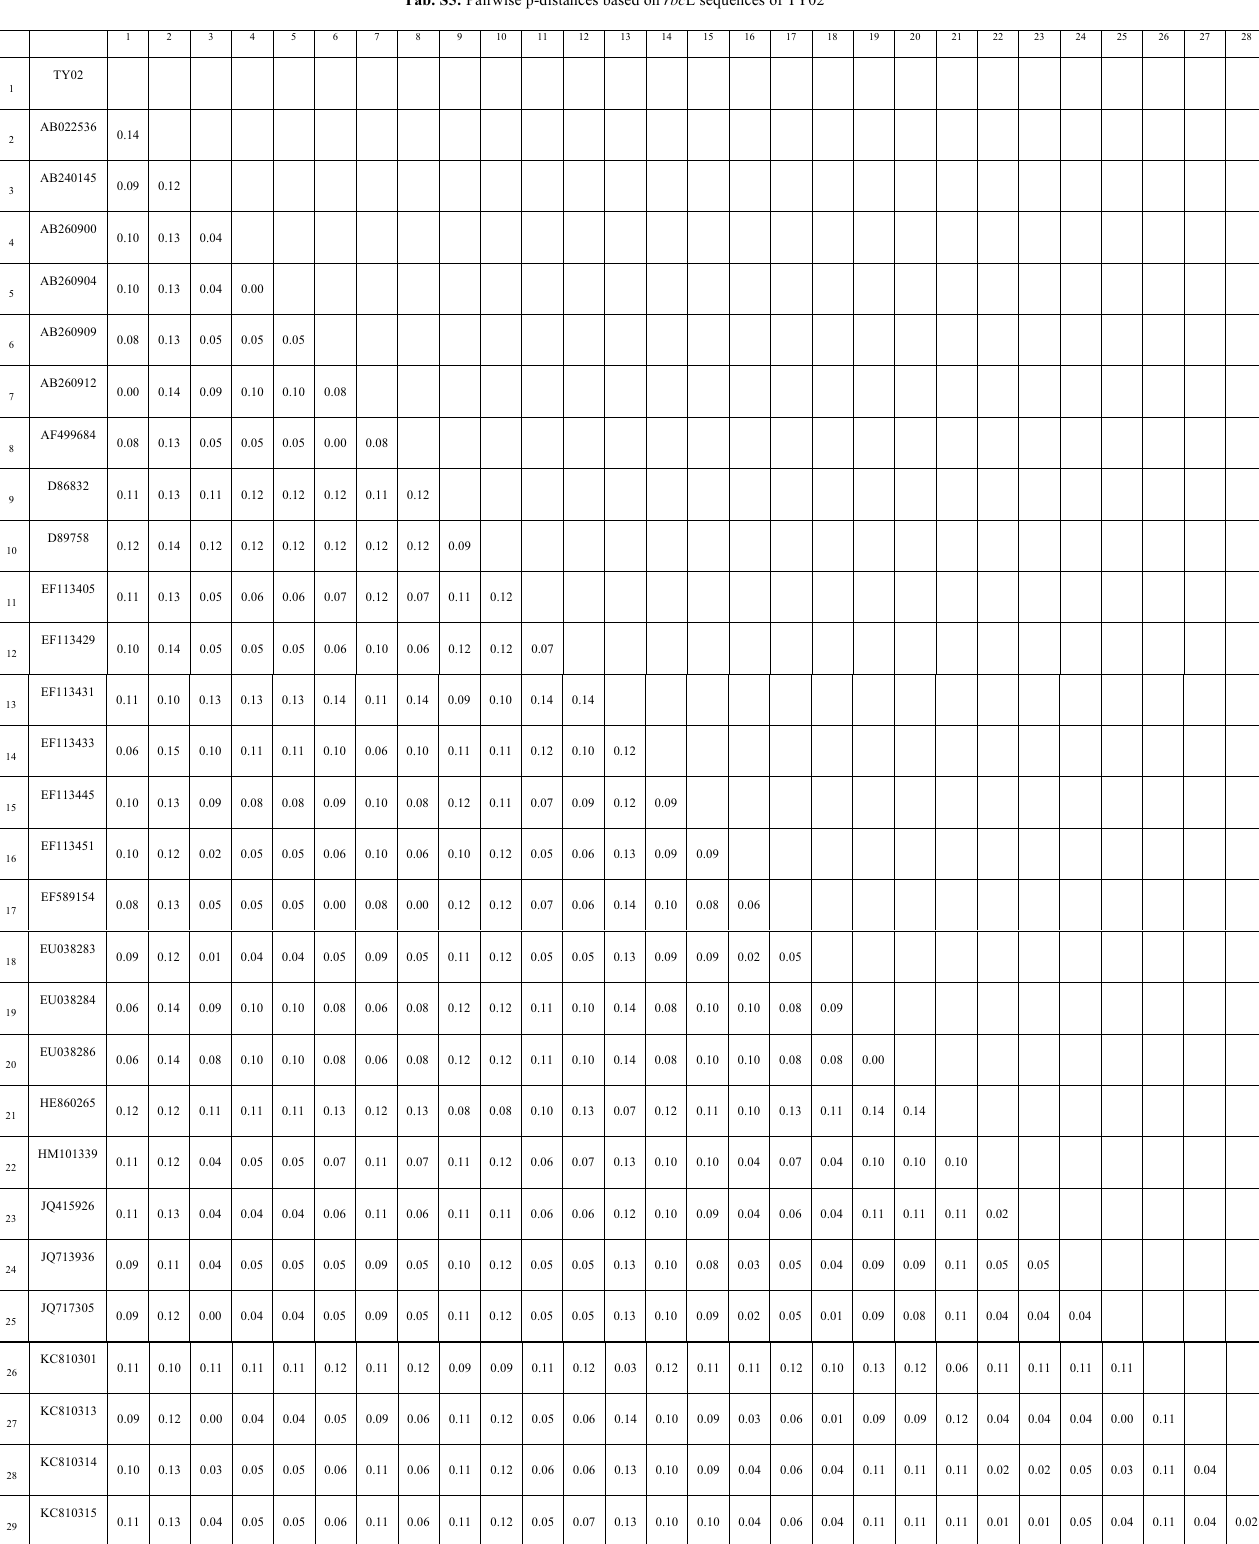
Tab. S5: Pairwise p-distances based on rbc L sequences of